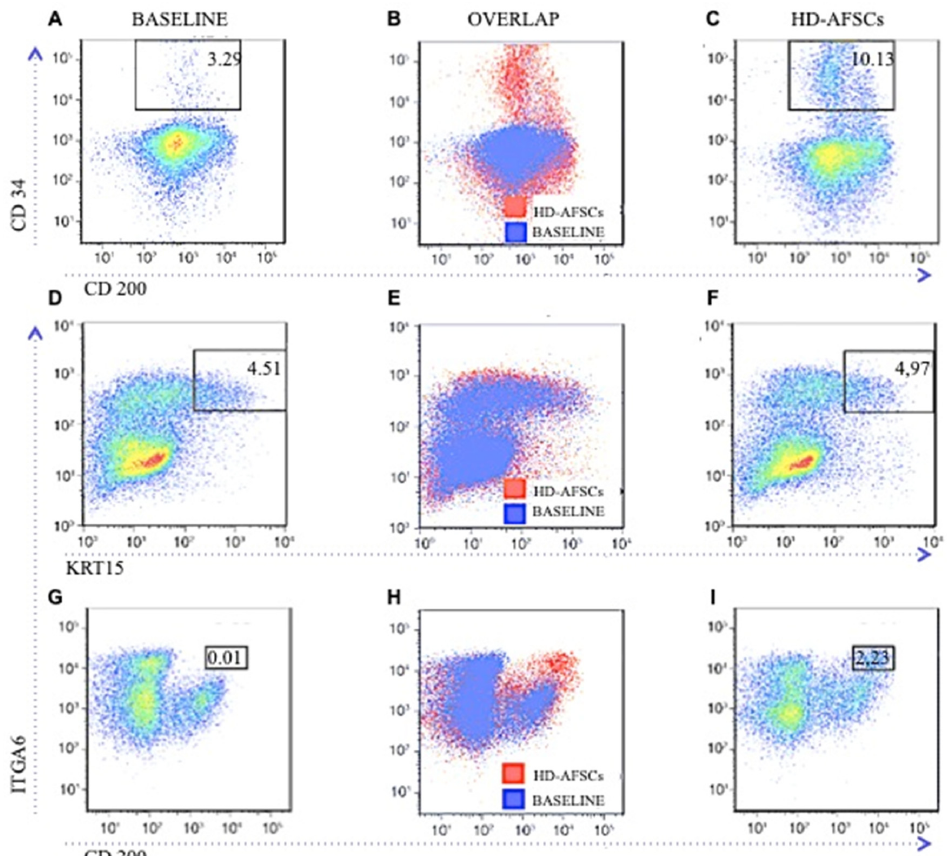
Figure 5. Preservation of KRT15 hair follicle stem cells in baseline and after HD-AFSCs treatment, with improvement of CD200, ITGA6, and CD34 progenitor cells in targeted area. Pseudocolor dot plots ( A , C , D , F , G , I ) or overlap graphs ( B , E , H ) from FACS analysis of epithelial cells stained with the indicated antibodies. Overlap graphs are plotted first with cells from HD-AFSCs-treated scalp, then layered over with cells from baseline. ( D – F ) Representative example showing KRT15 cells preserved in baseline ( p = 0.5). In contrast, a defined population of CD200 ITGA6 cells ( G – I ; p = 0.003) and CD34 cells ( A – C ; p = 0.011) were improved in HD-AFSCs-treated area. Numerical values represent percent cells in the gated population, of all cells plotted in the representative